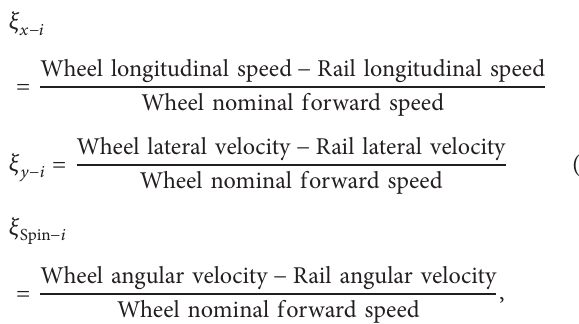
Figure 1: Diagram of radial bogie mechanism of locomotive